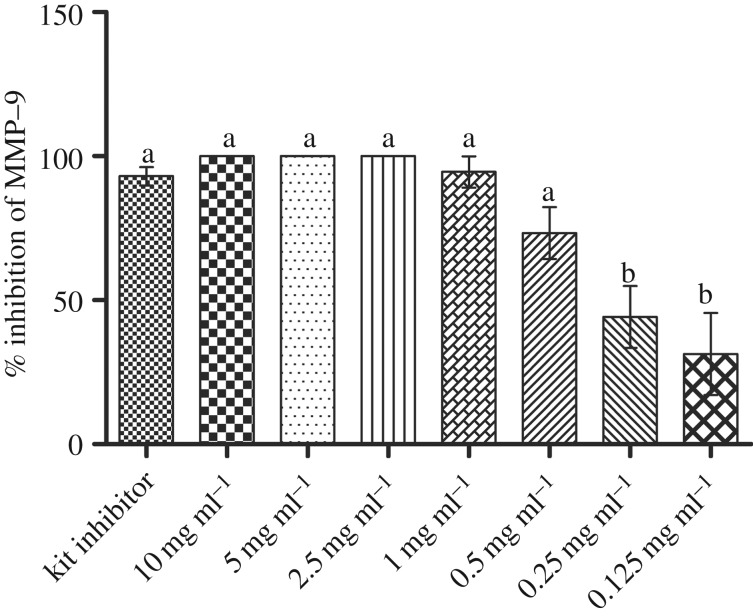
The per cent inhibition of rhMMP9 by different concentrations of PAMAM-COOH. The values are the means and standard deviations of the percentage. The groups labelled with the same letters on top of the bars are not significantly different (p > 0.05).